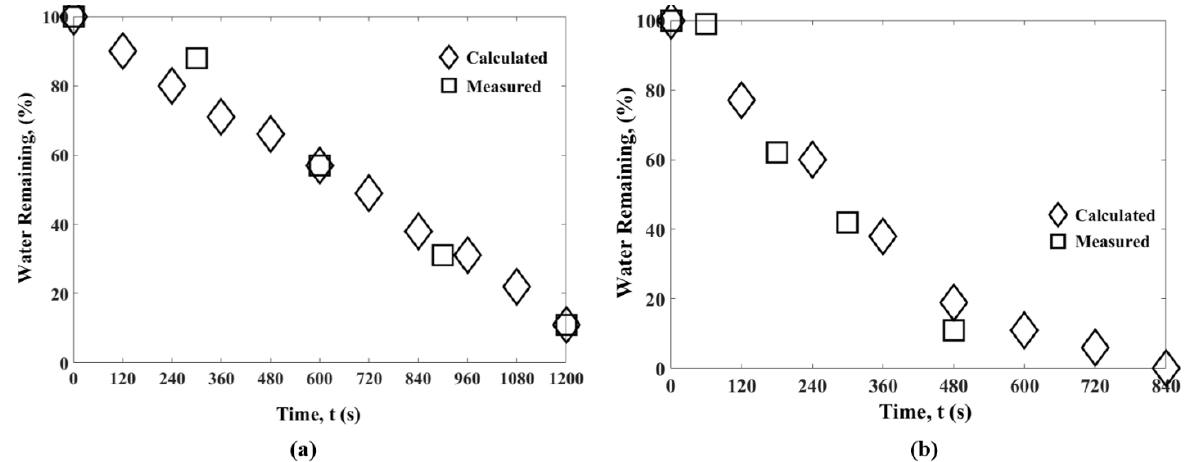
Figure 9. Comparison of the moisture loss of cylindrical foam with a v = 100 cm 3 dried at P in = 30% ( a ) and P in = 70% ( b ) .